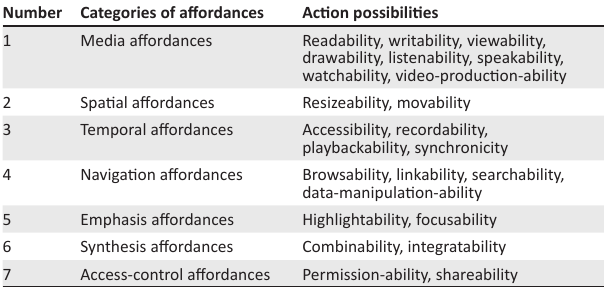
TABLE 1: Classification of affordances (adapted from Bower